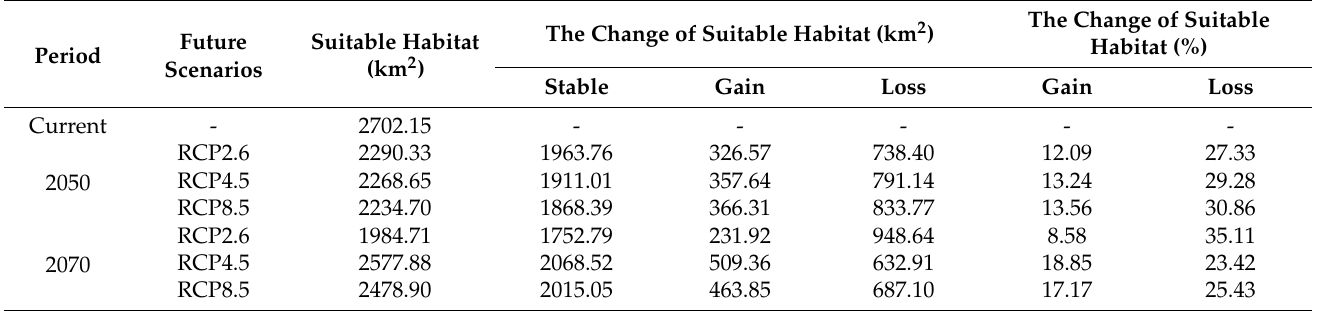
Table 2. Changes in suitable habitat of Siberian ibex in Taxkorgan Nature Reserve under different climate change scenarios.